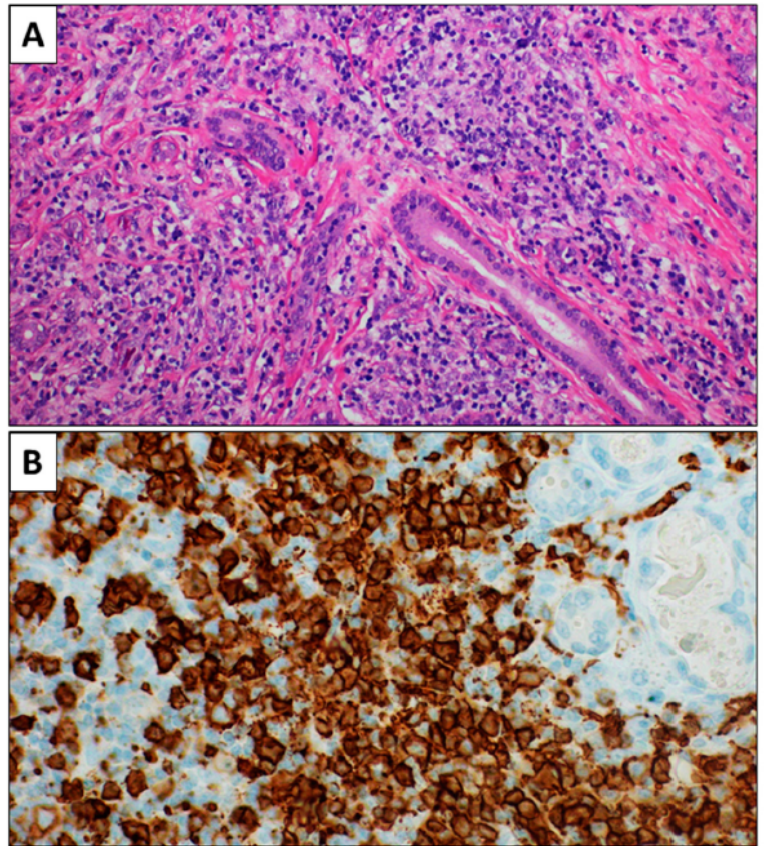
Figure 1. ( A ): Histological examination showing a lymphoid population in a fibrotic contest. A glan- dular duct is present (H&E, 20 × ). ( B ): Glandular lobules in the context of the lymphoid population are evident (CD20 immunohistochemistry, 40 ×